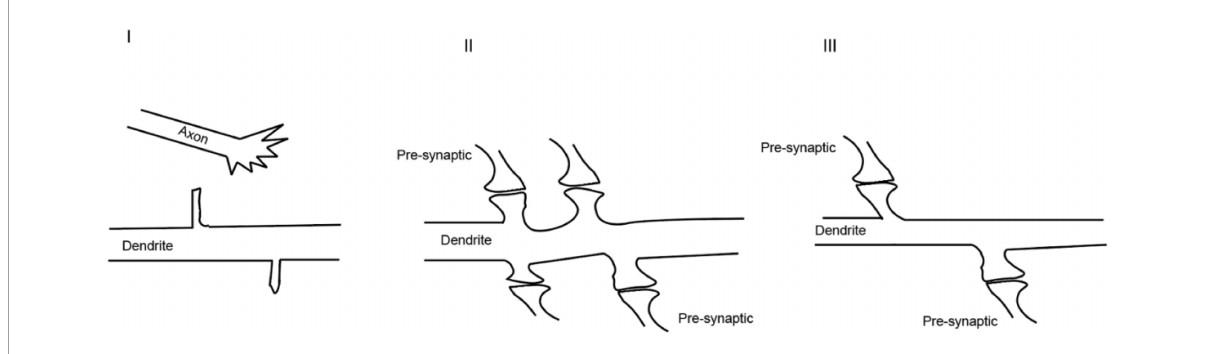
FIGURE3 Dynamic process of synaptogenesis: (I) axonal and dendritic growth; (II) excessive synaptogenesis; (III) pruning of the